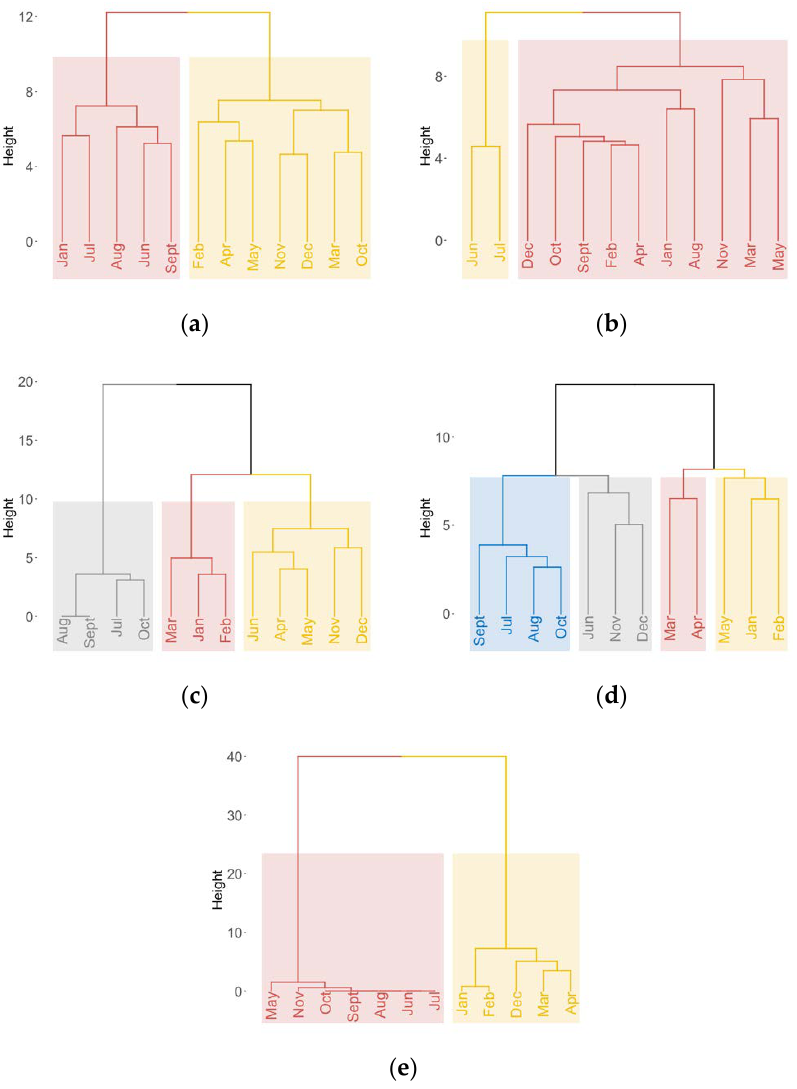
Figure 7. Cluster analysis of months with similar frequency of ( a ) cyclonic eddies; ( b ) anticyclonic eddies; ( c ) coastal upwelling; ( d ) filaments; ( e ) water mass intrusion in the Southern Gulf of California. Colors of clusters represent highest to lowest frequency/presence of events in the following order: red, yellow, grey, blue.